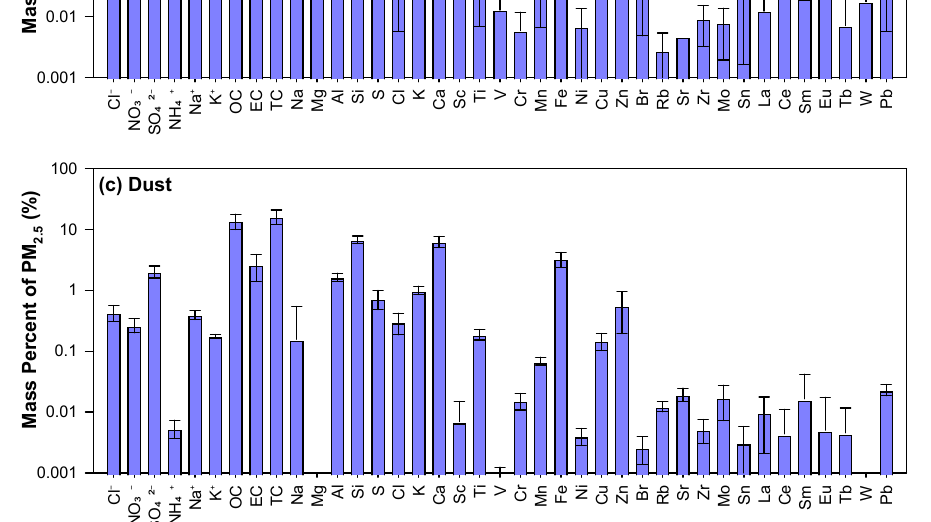
Figure 2. Average abundances (% of mass) for ( a ) NMHC species, ( b ) PM 2 . 5 components, and ( c ) resuspended dust components. Markers specific for diesel, gasoline, LPG, or tailpipe emissions are indicated in ( a ). Error bars indicate the standard deviations of multiple samples.